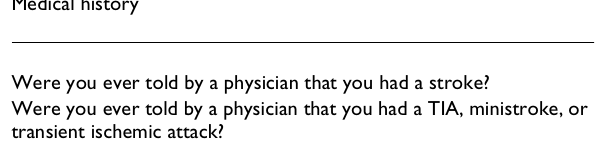
Table 1: Questionnaire for Verifying Stroke-Free Status (QVSFS) Medical